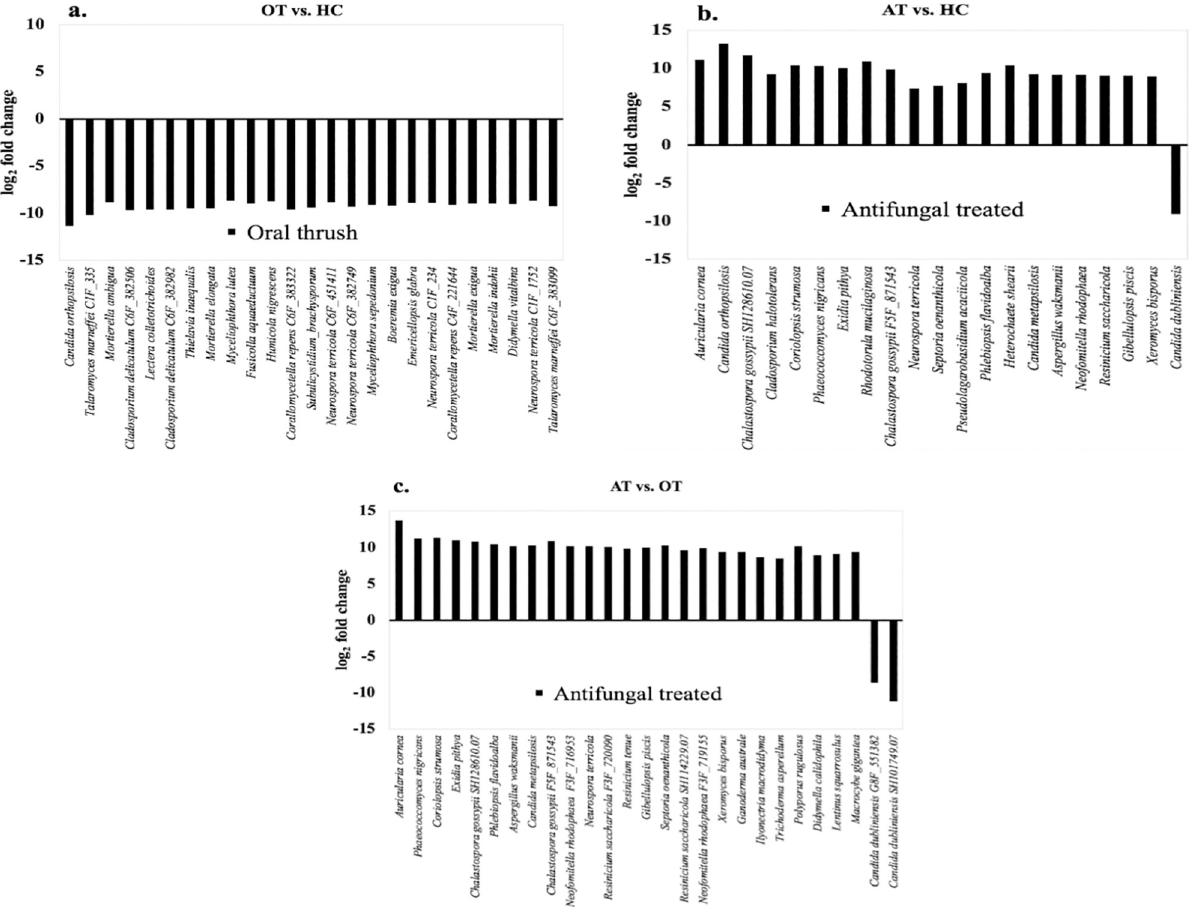
Fig 5. Significant differential abundance (p < 0.05) of fungal taxa within group pairs. a) OT vs. HC (Top 25 strains that showed significant downregulation in OT patients), b) AT vs. HC (A total of 20 strains showed significant upregulation in AT patients, while 1 species showed significant downregulation), c) AT vs. OT (Top 25 strains that showed significant upregulation in AT patients, while only 2 strains showed significant downregulation).